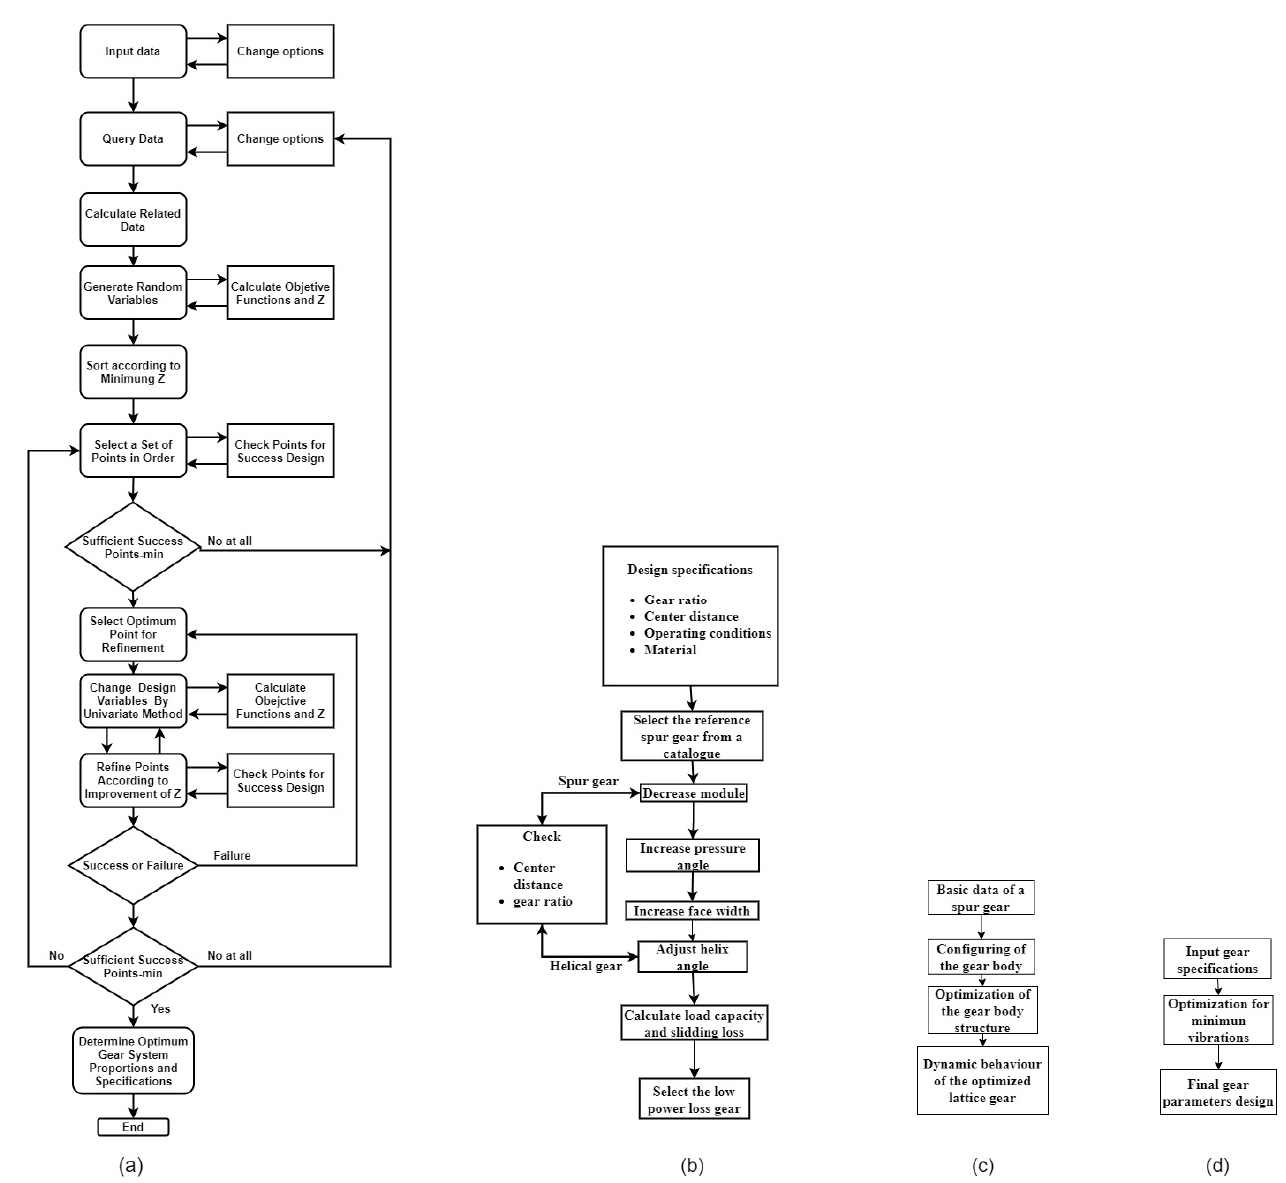
Figure 3. Design processes of spur gears which consider the minimization of vibration as a design goal. ( a ) Design procedure of a two-stage spur gear system through a min–max method combined with a direct search technique [100]. ( b ) The design process of parallel-axis gear by changing gear parameters [111]; ( c ) the design of gear body based on topology optimization [108]; ( d ) the general design process of pair gears for minimum vibrations found in the literature.